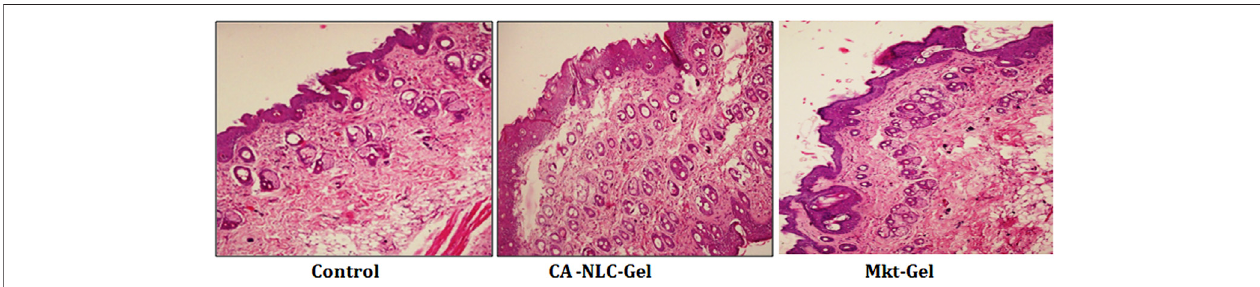
FIGURE 9 | Evaluation of the skin integrity when the skin of pig ear pinnae was treated with CA-NLC-gel and Mkt-gel, and of the untreated control, using histopathogy (hematoxylin and eosin staining). Photomicrogaphs were taken at × 200 magni fi cation.